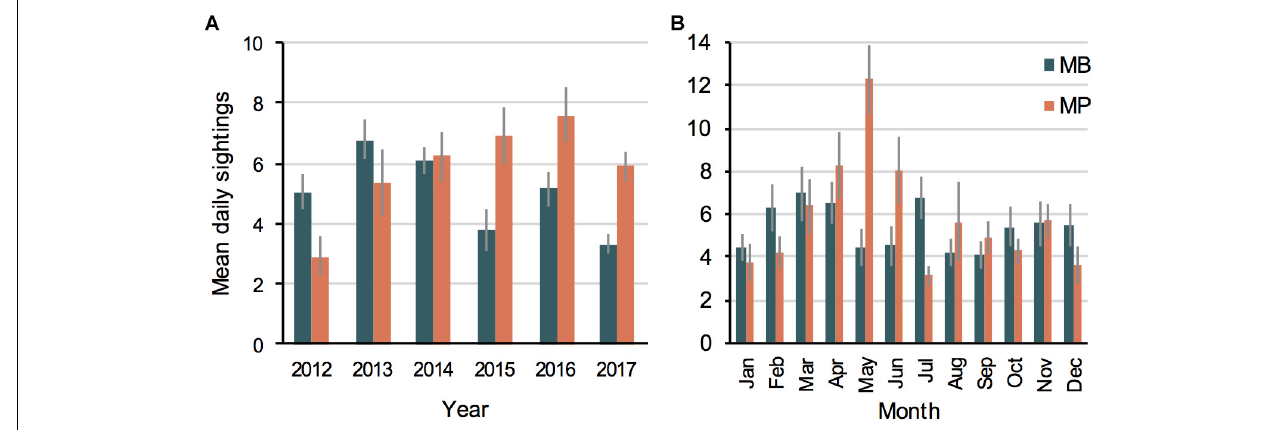
FIGURE 2 | The average annual (A) and monthly (B) manta ray sightings per unit effort (day) recorded between 2012 and 2017 in the Nusa Penida MPA at Manta Bay (MB) and Manta Point (MP) presented as the daily means ( ± 1 SE). Data from 2012 and 2015 is excluded from (B) due to lower year-round effort. (A) Sightings